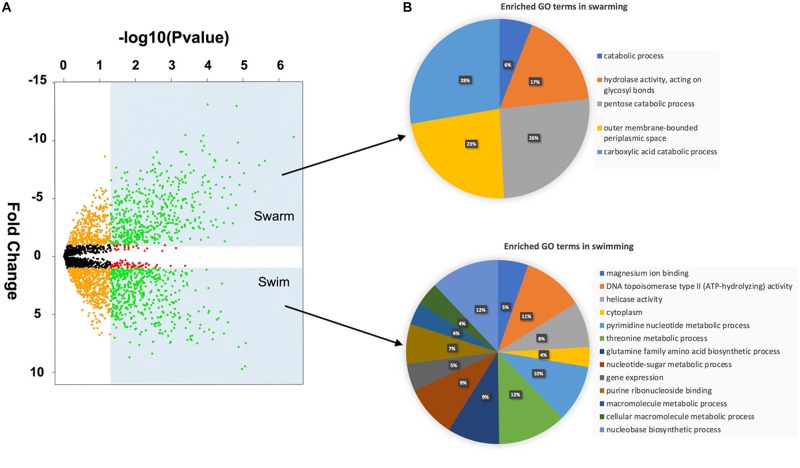
Volcano plot and GO enrichment of differentially abundant proteins: (A) Volcano plot -Green dots in the shaded regions are the proteins that have a p-value < 0.05 and FC > 1× (log scale). (B) Gene Ontology enrichment using ClueGO.